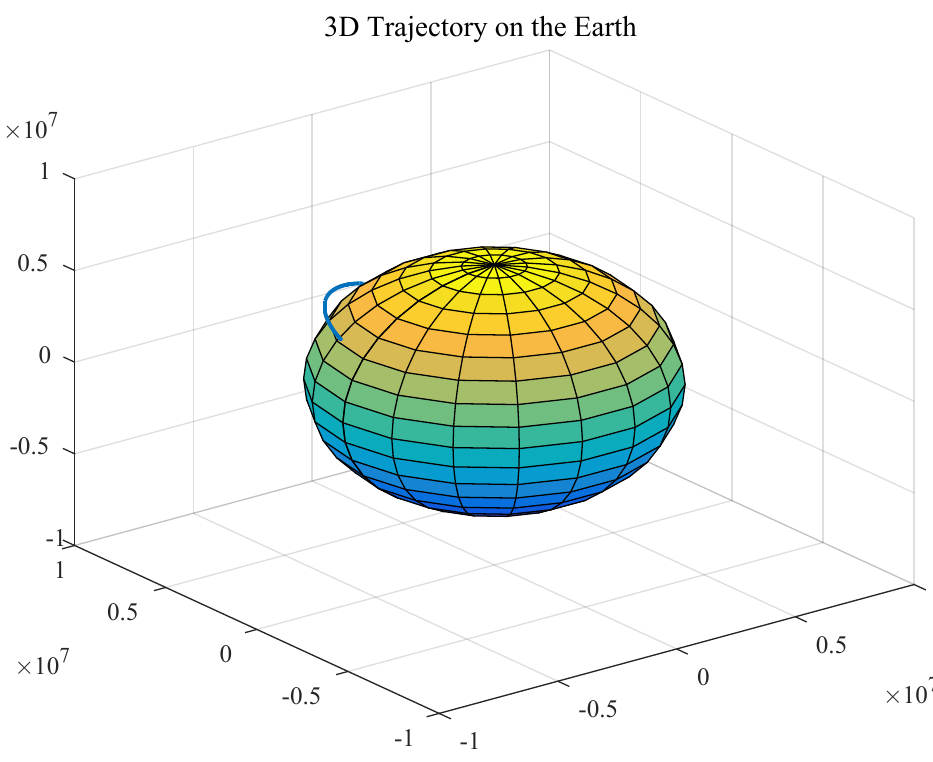
Figure 3. The trajectory of the aircraft on the